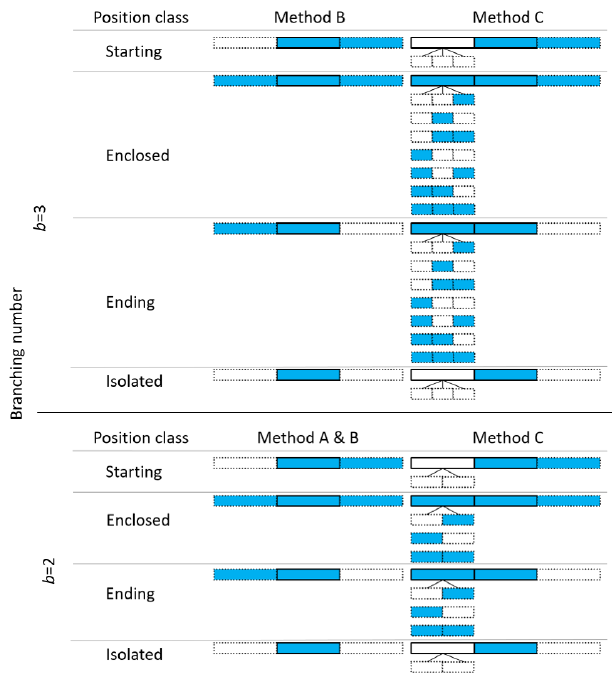
Figure 4. Comparison of position classes definition for methods A, B and C. For method A, no position classes differentiation is applied for b = 3. The dashed boxes indicate the time steps, which are analysed regarding their wetness state for the definition of the position class. Blue boxes indicate a wet time step, white boxes a dry time